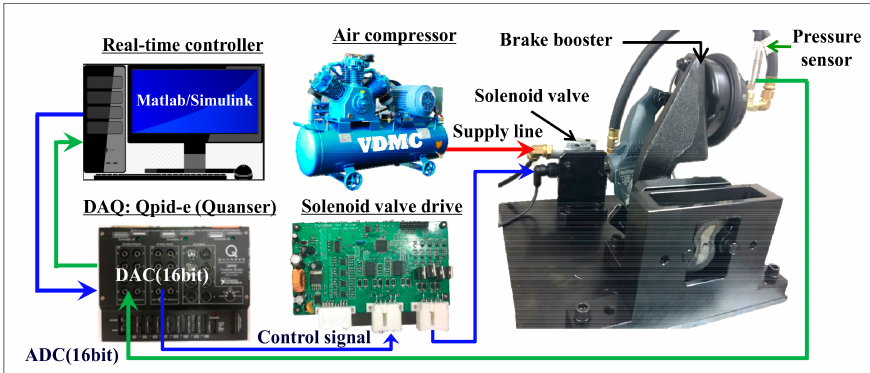
Figure 9. Schematic illustration of experimental setup.